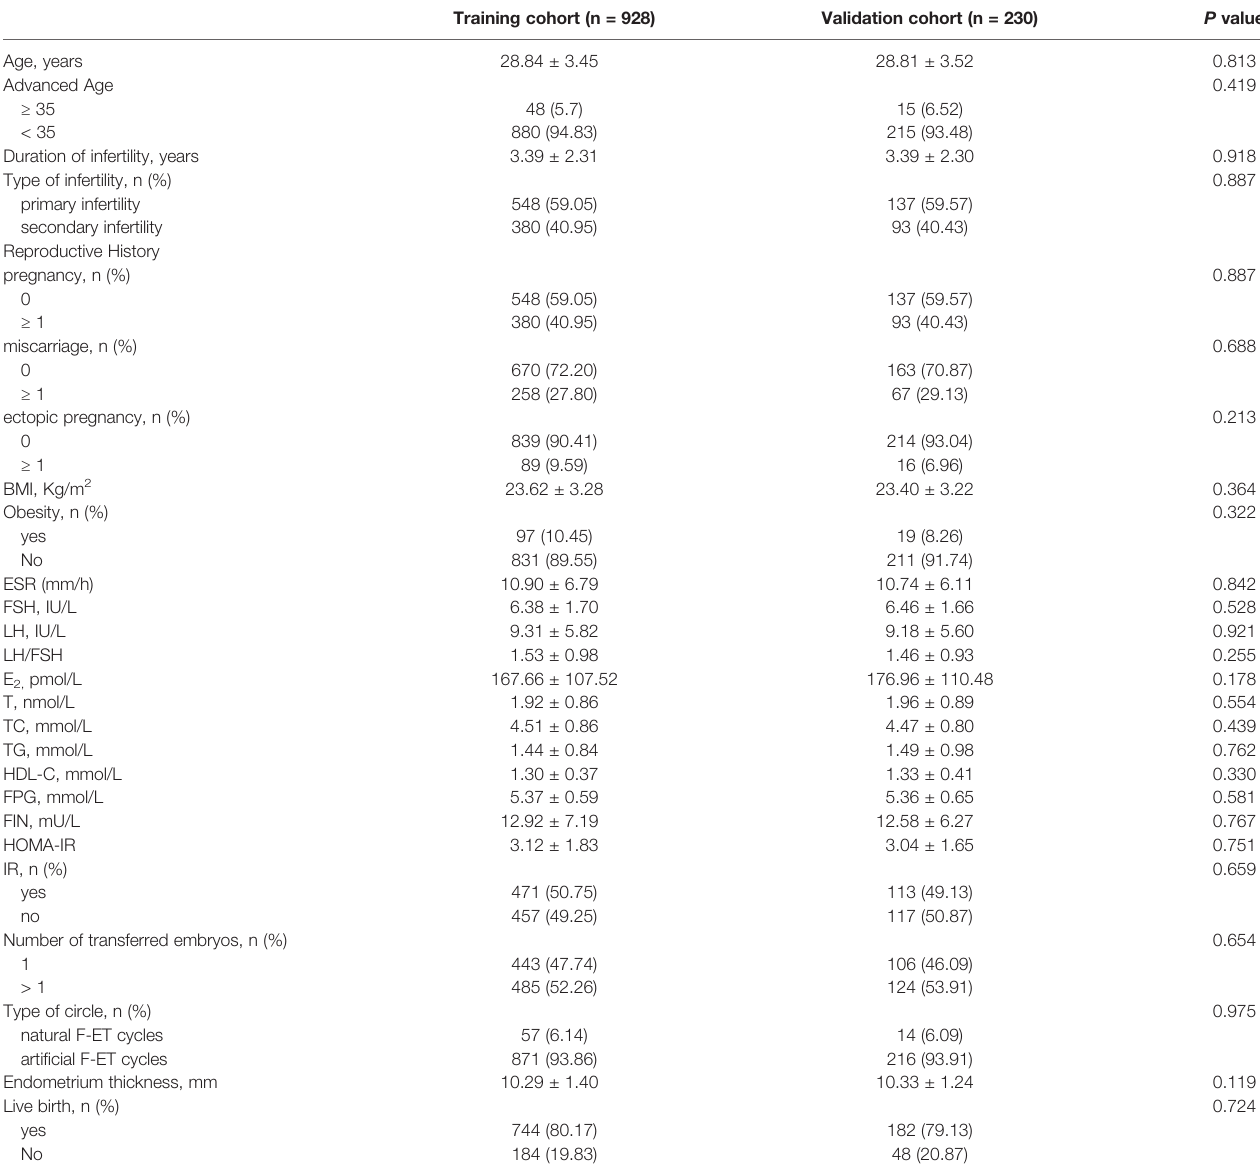
TABLE 1 | Participant